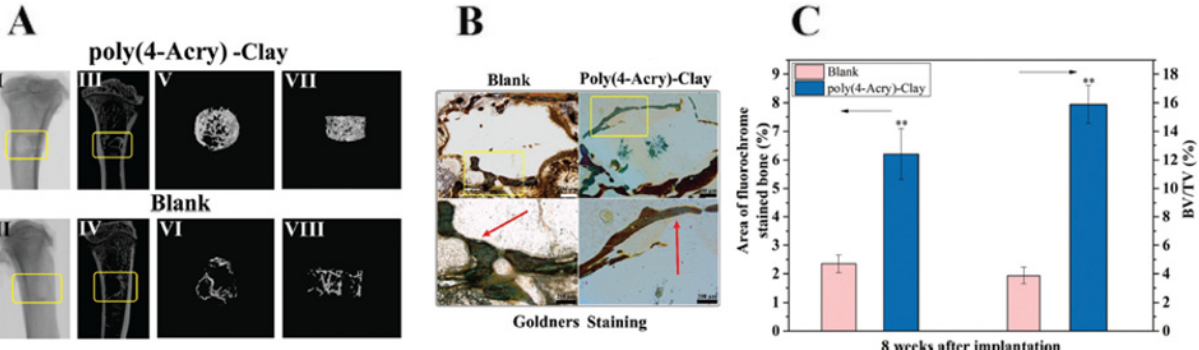
Figure 17. ( A ) Micro-CT characterization of implant and new bone formation (I and II), reconstruction images (III and IV) and reconstructed 3D models (V to VIII). ( B ) Histological staining observations of new bone formation, shown by the red arrows, 8 weeks after surgery for poly(4-acry)–clay nanocomposite hydrogel with a 5% nanoclay concentration. ( C ) Relative bone formation assessment 8 weeks after implantation. (Adapted with permission from [81]. Copyright 2013, Royal Society of Chemistry).